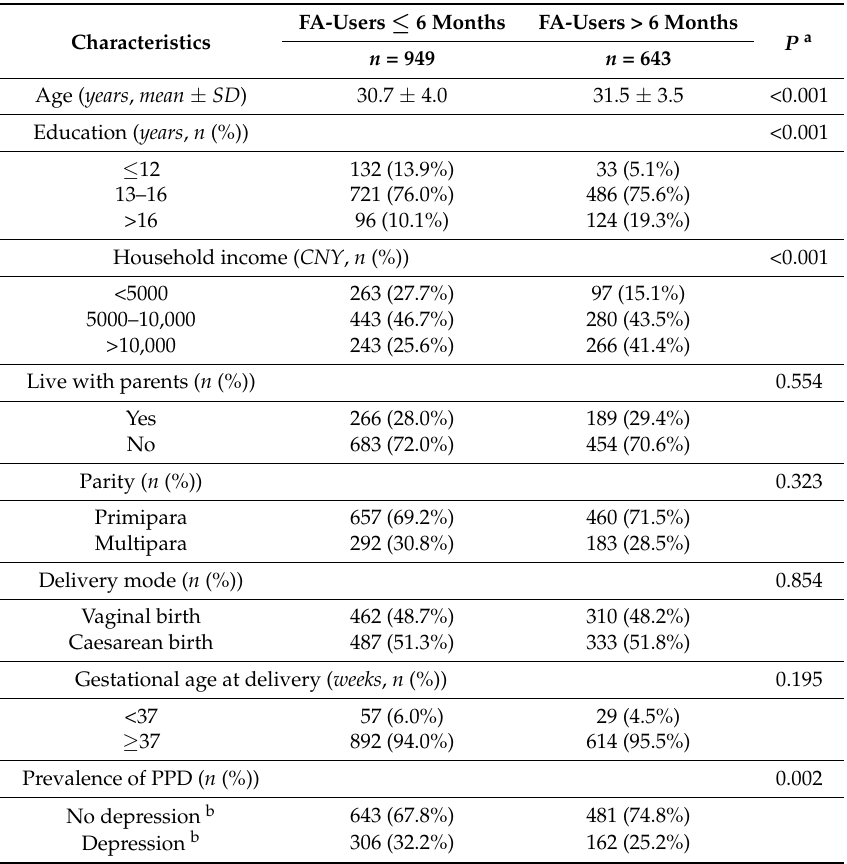
Table 1. Characteristics of study participants and prevalence of PPD according to the duration of FA